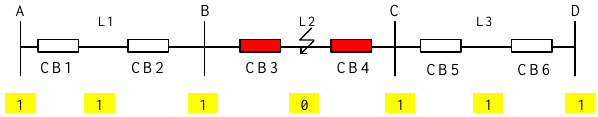
Figure 1. Fault area boundary breakers ’ schematic diagram of line fault.